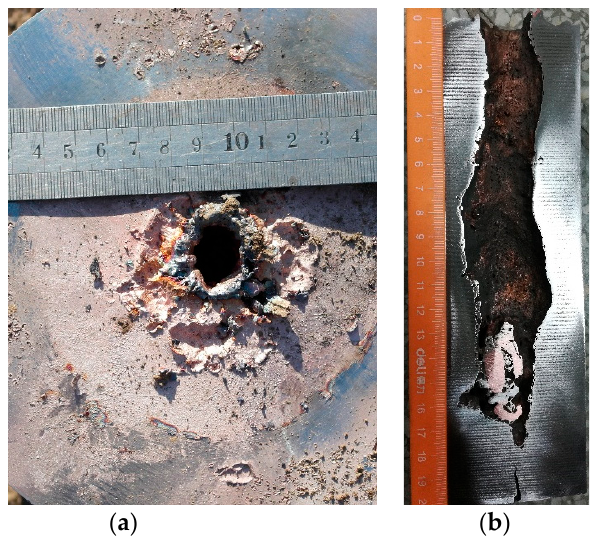
Figure 22. Target plate morphology: ( a ) into the hole; ( b ) perforation.